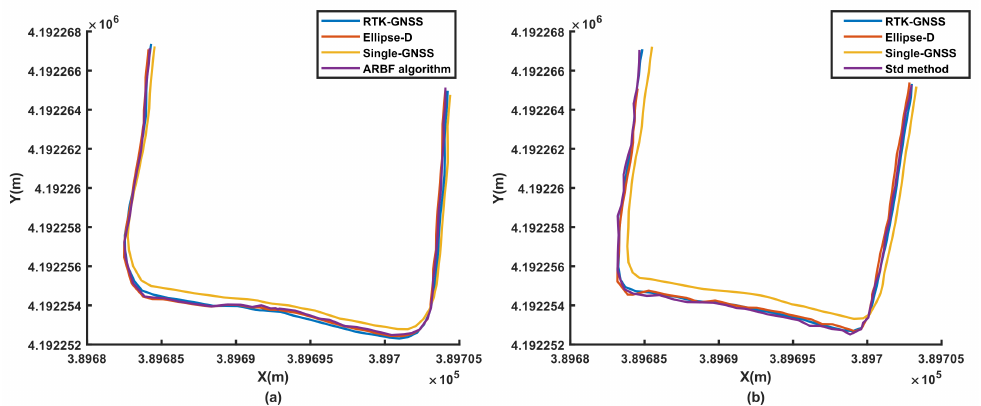
Figure 10. Experimental results from grass: ( a ) position prediction results of ARBF algorithm; ( b ) position prediction results of the Std method.